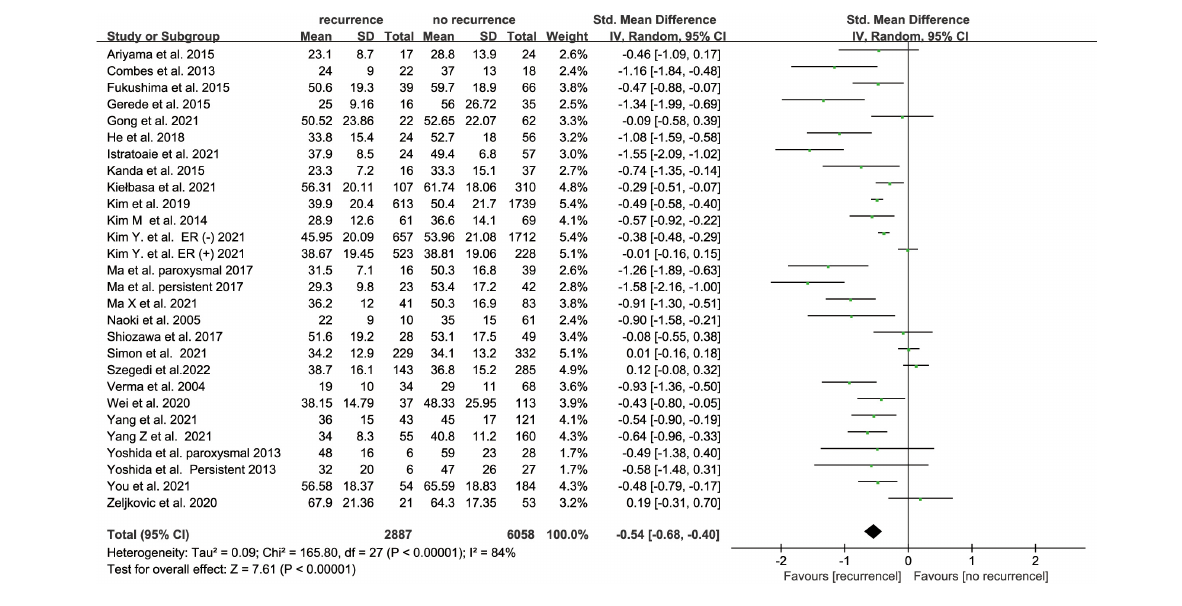
FIGURE4 Forest plot showing the difference in LAA emptying flow velocity between patients with and without AF recurrence after catheter ablation.